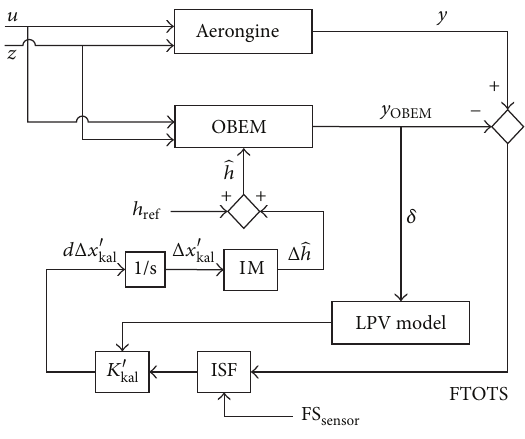
Figure 7: Structure of the